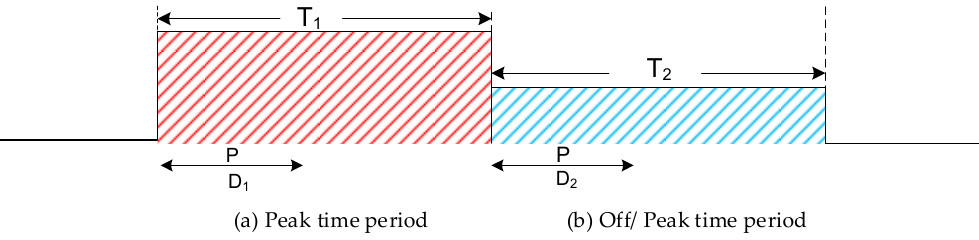
Figure 3. Amount of data over time: asynchronous period.